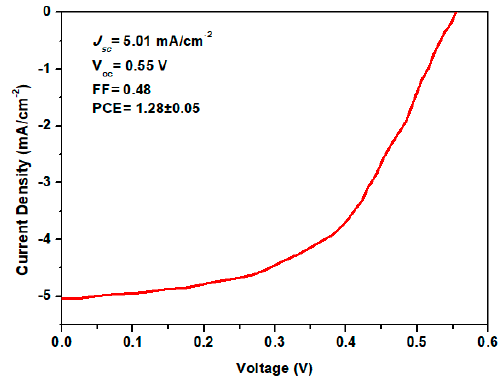
Figure 6. J-V characteristics of ZnPc Schottky solar cell under STC.